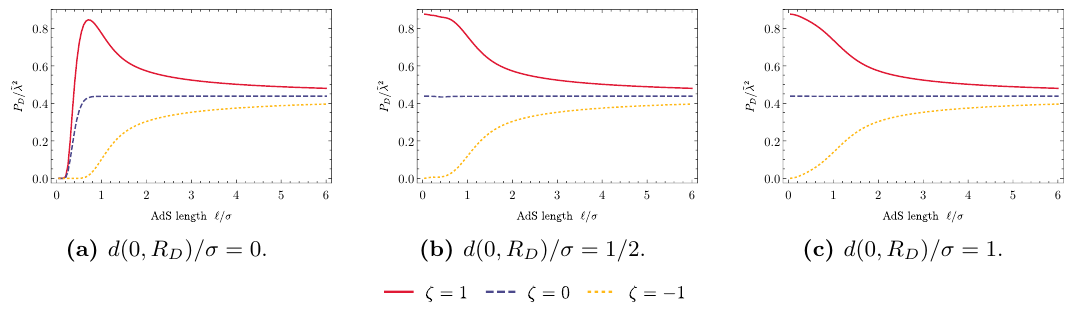
Figure 1 . The transition probability P D of a static detector with energy gap (cid:10) (cid:27) = 1 = 100 is plotted as a function of the AdS length ‘=(cid:27) for each of the three boundary conditions (cid:16) = f 1 ; 0 ; (cid:0) 1 g . Plots (a), (b), and (c) correspond to detectors located at di(cid:11)erent proper distances d (0 ; R D ) =(cid:27) away